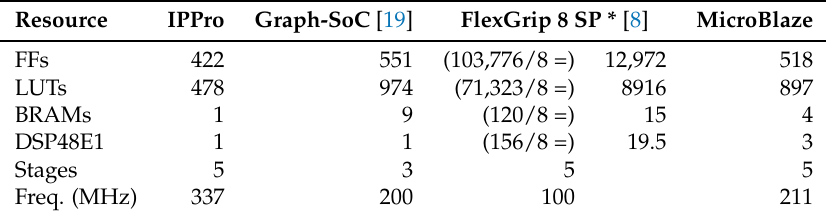
Table 4. Comparison of IPPro against other FPGA-based processor architectures in terms of FPGA resources used and timing results achieved.